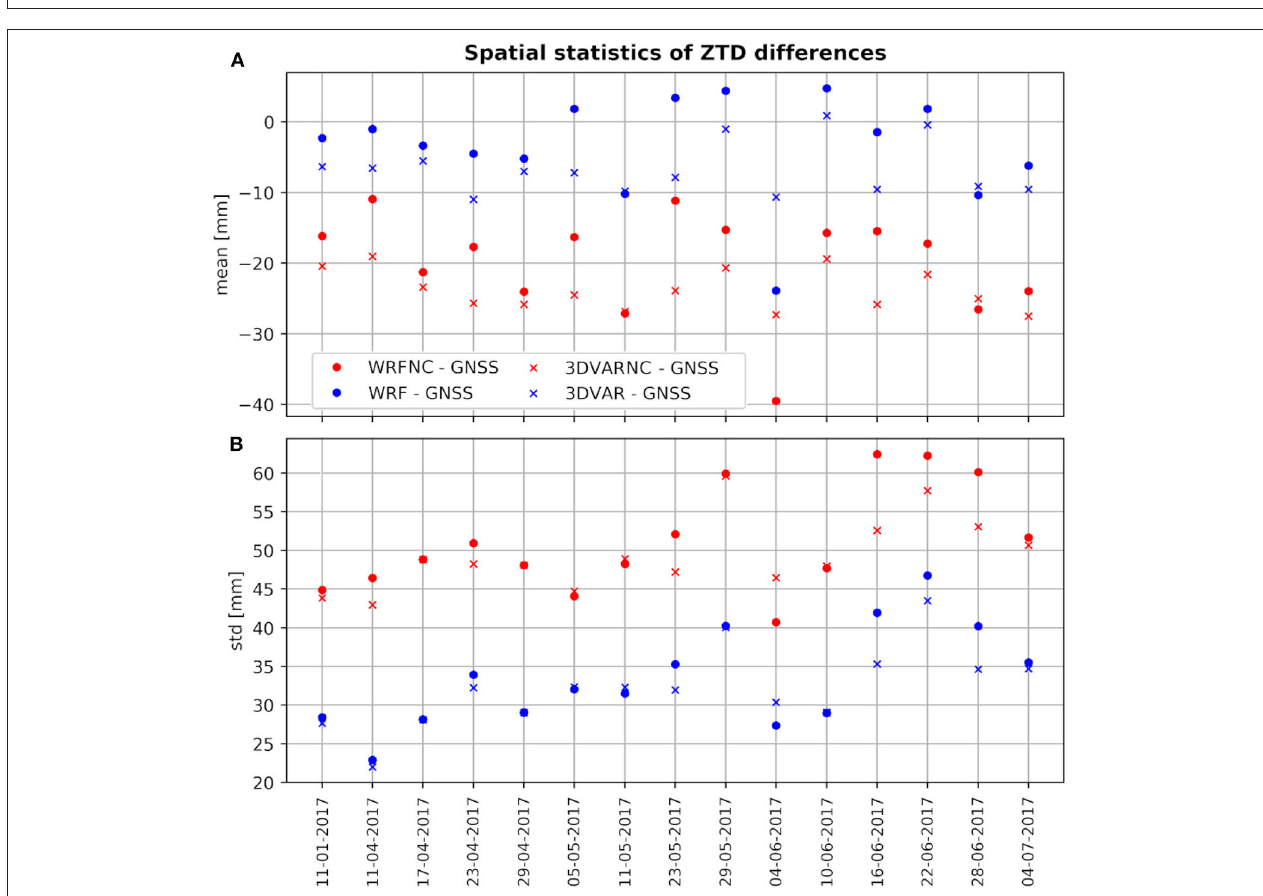
FIGURE 8 | Scatterplot of the GACOS ZTD values and the InSAR DEM height (A) as well as of the 3DVAR ZTD values and the WRF model height (B) .